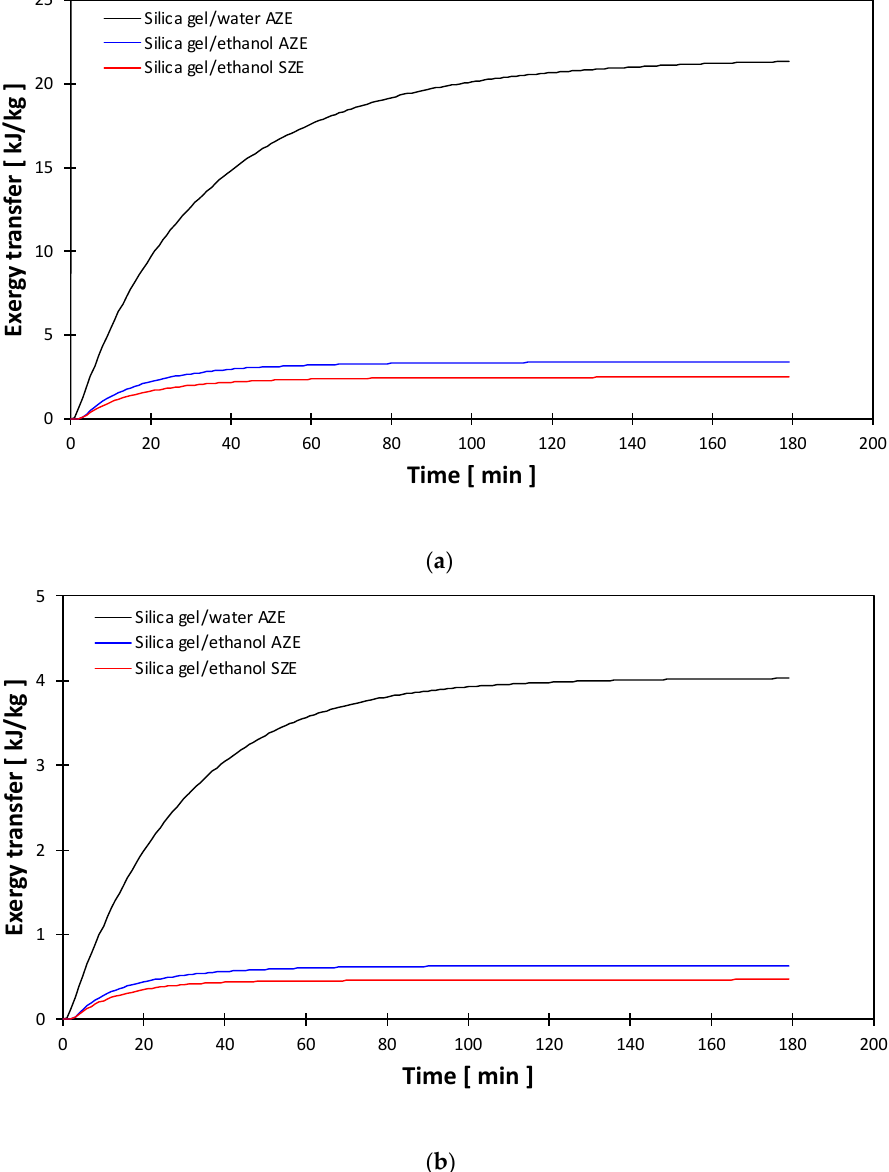
Figure 8. Exergy transfer during ( a ) heat charging and ( b ) heat discharging.